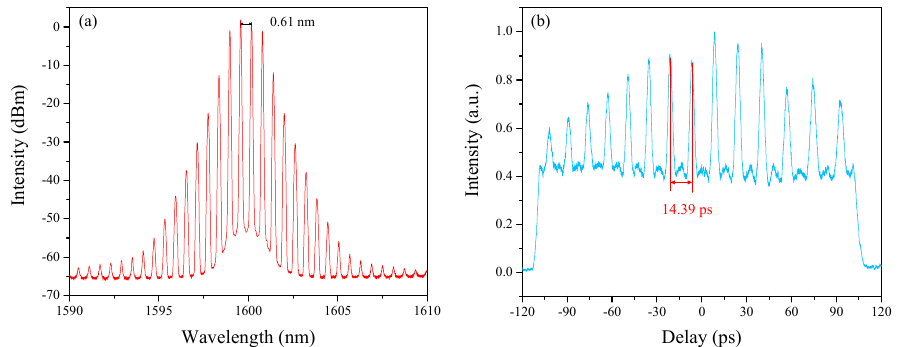
Figure 7. HRR single-soliton train when the length of intra-cavity PMF is 10 m. ( a ) Optical spectrum. ( b ) Corresponding AC traces.